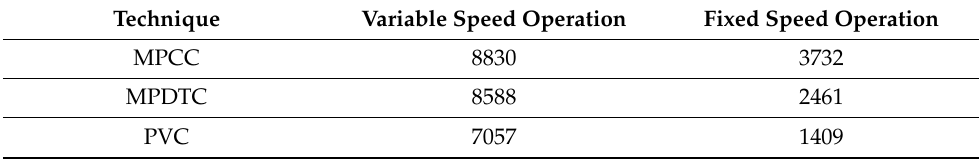
Table 3. Comparison in terms of performed commutations by the predictive